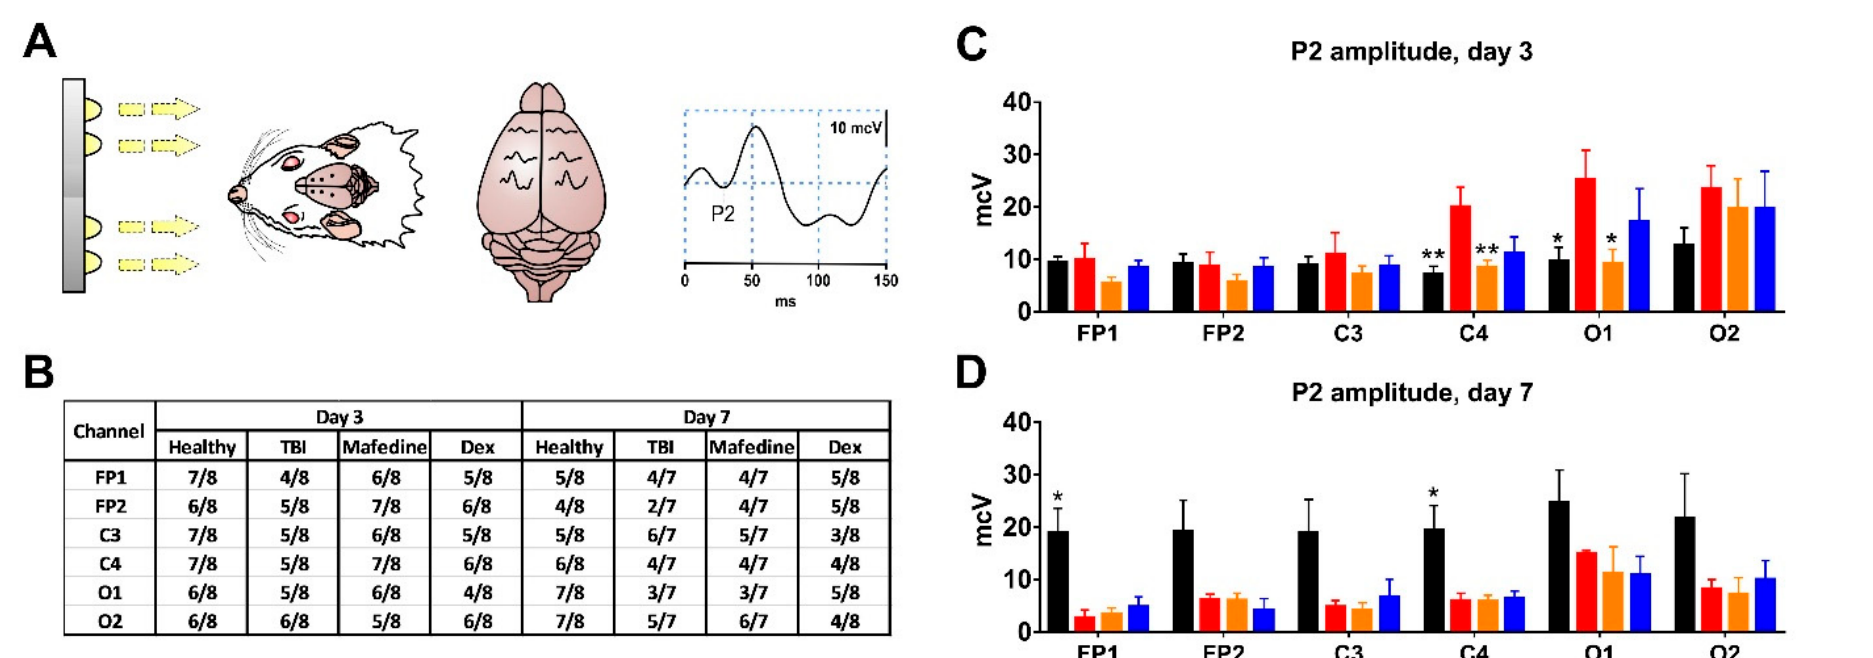
Figure 5. ( A ) a schematic representation of the VEP acquisition process. Right: an example of obtained VEP curve with a highlighted P2 peak; ( B ) P2 peak incidence in experimental animals at post-TBI days 3 and 7; ( C , D ) P2 peak amplitudes in channels FP1, FP2, C3, C4, O1, and O2 at post-TBI days 3 and 7. Black healthy controls, red TBI, orange TBI + mafedine, blue TBI + dexmedetomidine (Dex). Dex dexmedetomidine; * p < 0.05, ** p <0.01 vs. TBI.